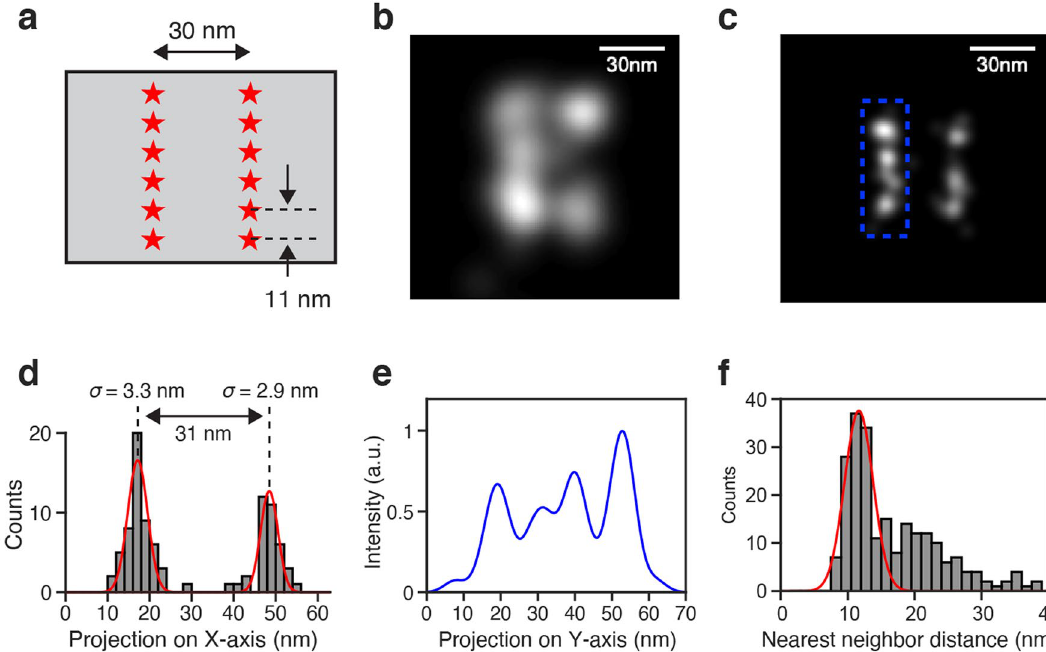
Figure 3. Tetra-gel expansion microscopy enables increased STORM resolution while preserving original structure. ( a ) Rectangular DNA origami design featuring labeling sites spaced 11 nm apart, organized in two rows spaced 30 nm apart. ( b ) Representative STORM image of a single rectangular origami object without gel. ( c ) Representative STORM image of a single rectangular origami object in tetra-gel, expanded 2.5X. ( d ) Projection of STORM localizations onto X-axis from the image shown in ( c ). Red curves show Gaussian fits. ( e ) Projection of blue area of image in c onto Y-axis. ( f ) Histogram of nearest neighbor emitter distances on the individual rows within rectangular origami objects (N = 93 rows). Post-expansion distances represent effective distances after scaling for the expansion factor. Red curve shows Gaussian fit of the first peak, mean ± standard deviation: 11.7 ± 3.0